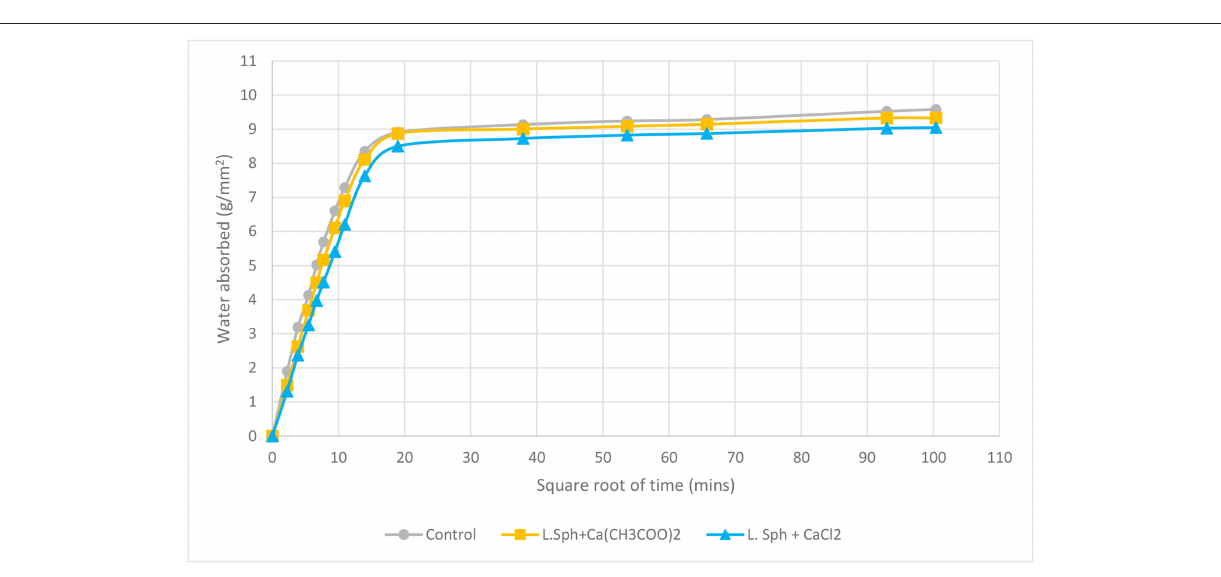
FIGURE 10 | Average water absorption vs. immersion time for cracked mortar